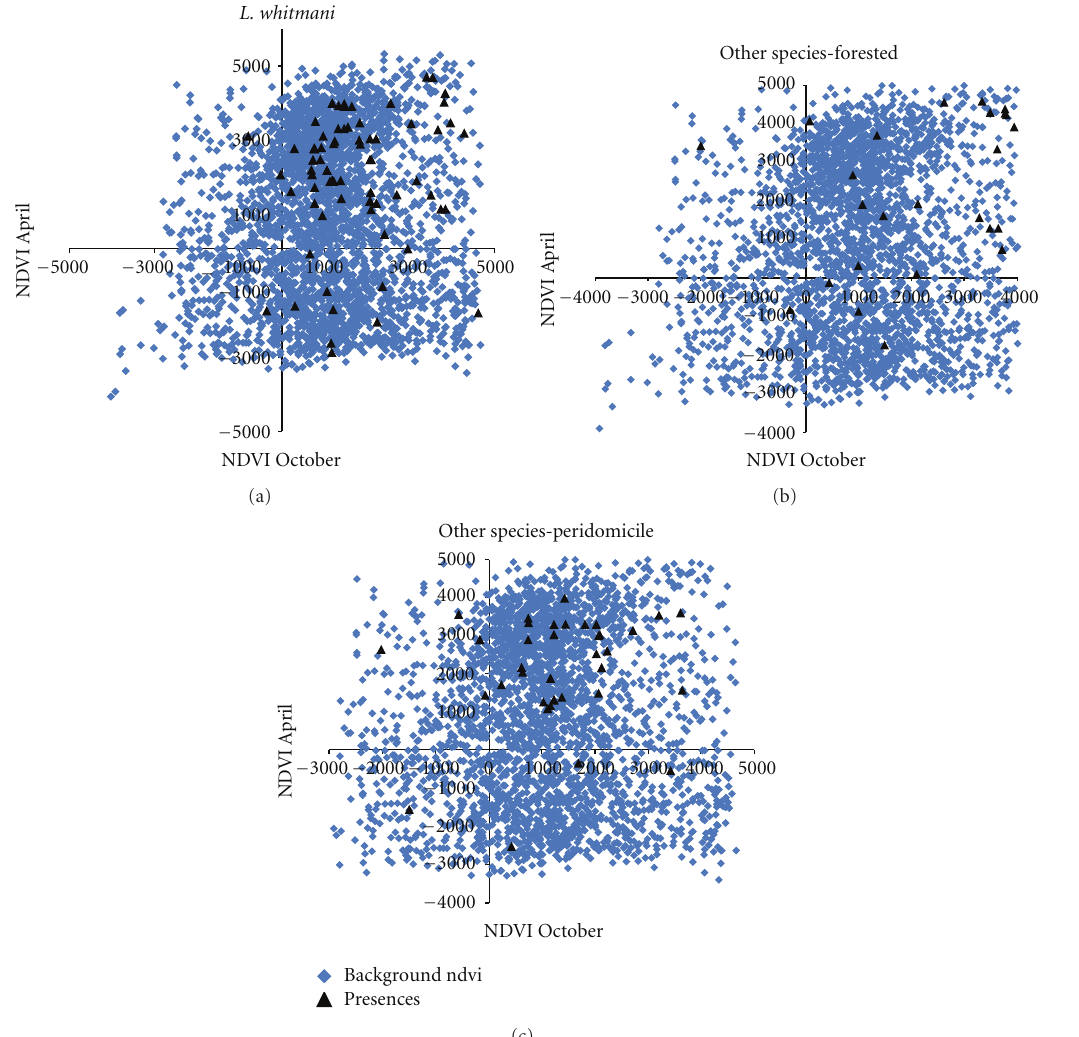
Figure 3: Summary of environmental characteristics of known occurrences (i.e., traps positive) for Lutzomyia whitmani versus two sets of other species (one of forested sites, one of peridomiciliary sites; see text for explanation). Occurrences shown as triangles are depicted against the background of conditions available across the study area (in gray). Environmental conditions of NDVI of October and April, Amaraj´ı, Pernambuco, Brazil,